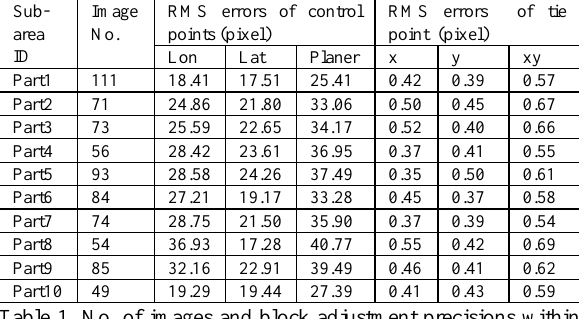
Table 1. No. of images and block adjustment precisions within the ten subareas